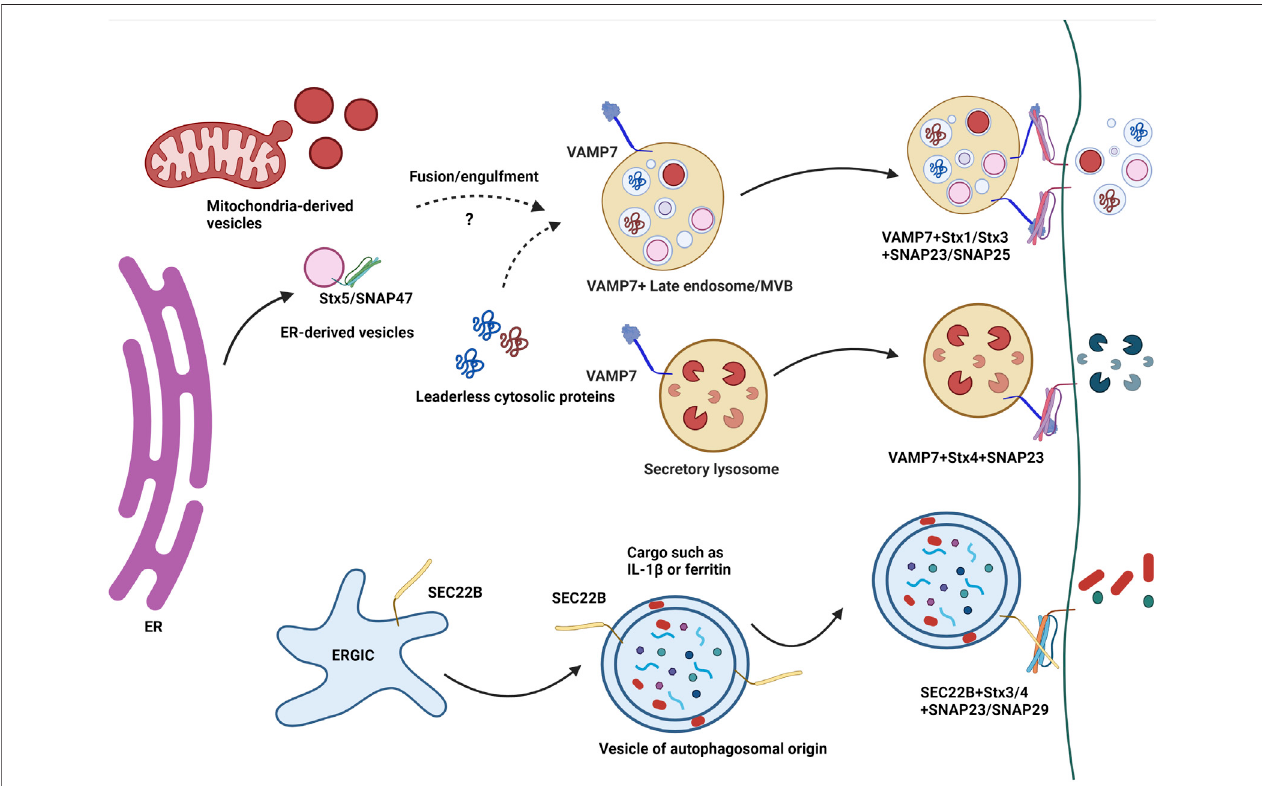
FIGURE2| Asimpli fi ed model oftheroleofSNAREs in unconventionalsecretion.Unconventionalsecretion ofextracellularvesicles has beenshown todepend on v-SNAREs such as VAMP7 and SEC22B. ER-derived vesicles and mitochondria-derived vesicles may merge with VAMP7 + late endosomes/MVBs in a SNARE dependent manner involving VAMP7, Stx5 and SNAP47. Lysosomal exocytosis i.e. the unconventional secretion of lysosomal contents upon the fusion of lysosomes with the plasma membrane involves VAMP7 along with t-SNARES Syntaxin4 and SNAP23. Vojo Deretic ’ s group has shown the involvement of SEC22B with SNAP23 or SNAP29 and PM SNAREs Syntaxin3/4 in the unconventional secretion of leaderless proteins such as IL-1 β and ferritin .